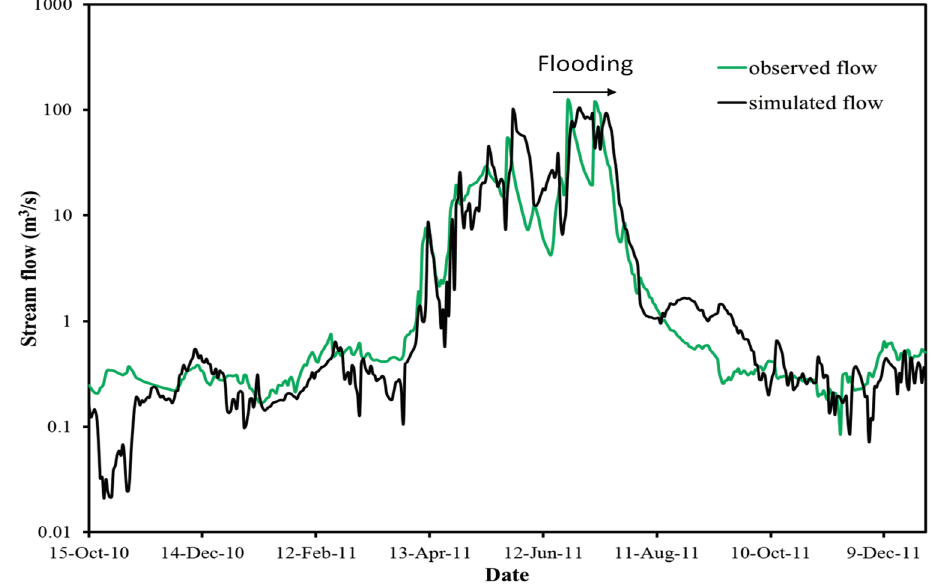
Figure 5. Comparison of observed and simulated stream flows with the GSSHA model at the outlet of the study area during the validation